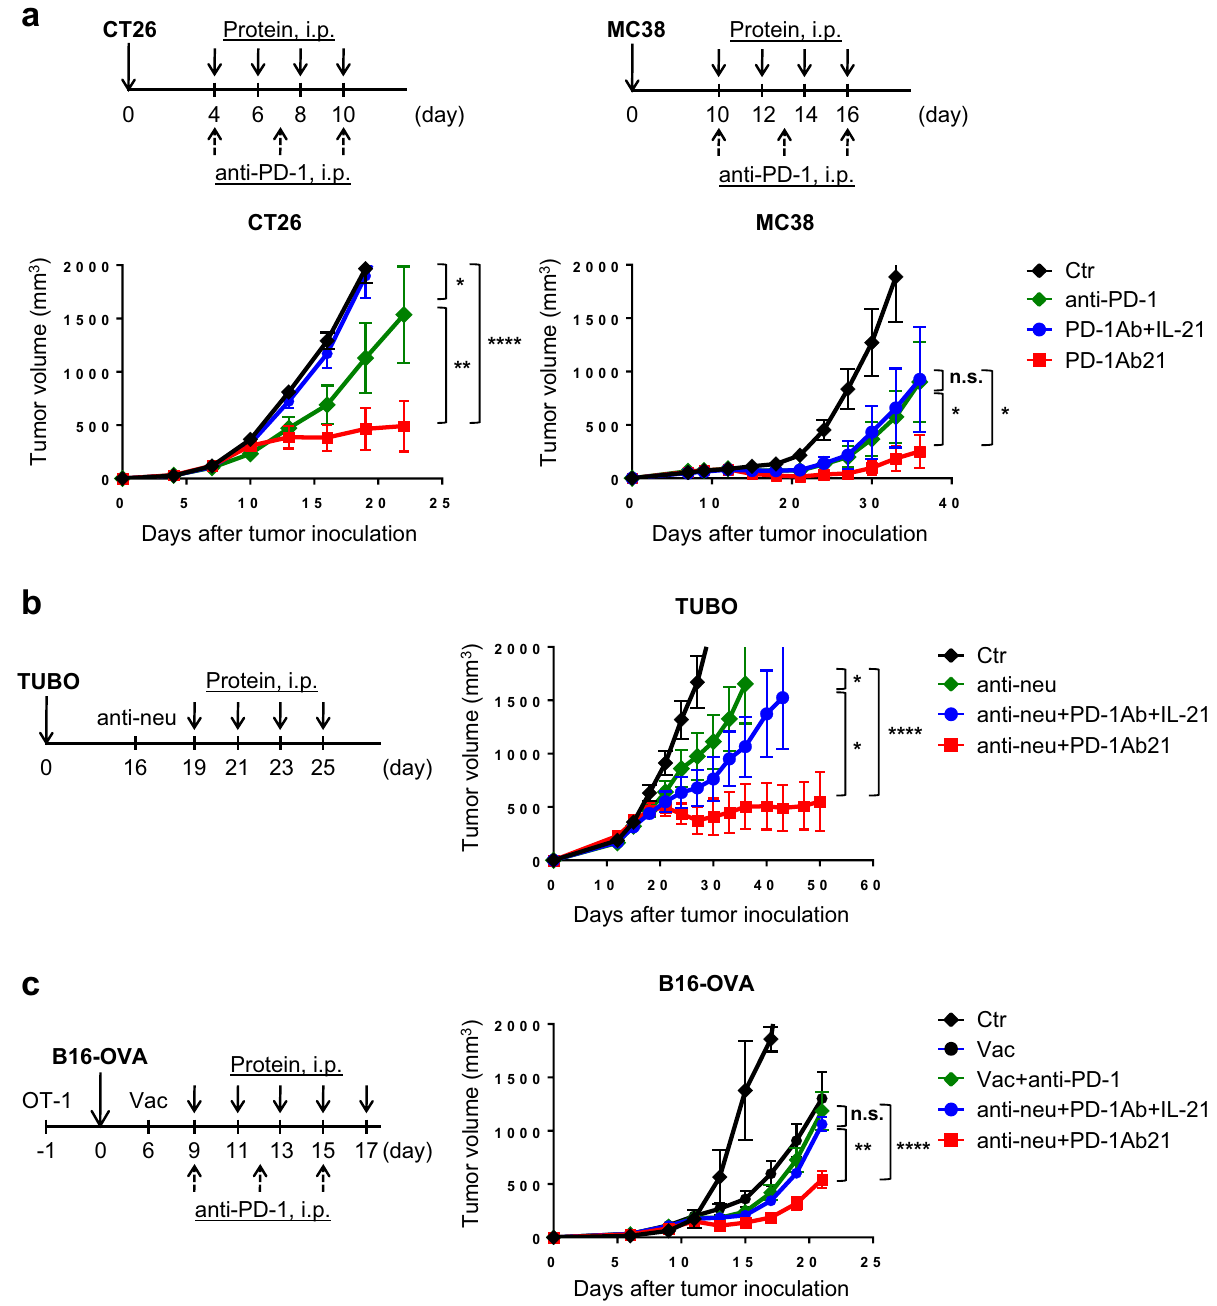
Fig. 5 Superior antitumor effect of PD-1Ab21 treatment. a Balb/c mice transplanted s.c. with CT26 cells (left) or C57BL/6 mice transplanted s.c. with MC38 cells (right) were treated with anti-PD-1, PD-1Ab + IL-21, or PD-1Ab21 ( n = 5 mice /group). b Balb/c mice ( n = 5 mice /group) transplanted s.c. with TUBO cells were treated with anti-Her2/neu antibody alone or in combination with PD-1Ab + IL-21 or PD-1Ab21. c C57BL/6 mice ( n = 5 mice /group) transferred with 1 × 10 6 naïve CD90.1 + OT-1 cells 1 d before inoculation of B16-OVA cells were immunized with poly I:C and OVA 257-264 peptide, followed by treatment with anti-PD-1, PD-1Ab + IL-21, or PD-1Ab21. Tumor length (a) and width (b) were measured and tumor volume was calculated as (ab 2 /2). Tumor growth is shown as mean tumor size ±SEM over time. Results were compared using two-way ANOVA followed by Tukey ’ s multiple comparison test. a CT26: * p = 0.0167, ** p = 0.0024, **** p < 0.0001; MC38: * p = 0.0445 (anti-PD-1 vs. PD-1Ab21), * p = 0.0242 (PD-1Ab + IL-21 vs. PD-1Ab21). b * p = 0.0223 (anti-neu vs. anti-neu + PD-1Ab + IL-21), * p = 0.0335 (anti-neu + PD-1Ab + IL-21 vs. anti-neu + PD-1Ab21), **** p < 0.0001. c ** p = 0.0015, **** p < 0.0001, n.s. not signi fi cant. One representative experiment out of three independent experiments is PD-1Ab21 further stimulated the robust expansion of OT-1 cells, and Supplementary Fig. 8a, b). However, the non-OT-1 CD8 + T cells did not increase in tumors of PD-1Ab21-treated mice. leading to a systemic high frequency of OT-1 cells, especially in (Supplementary Fig. 8c). The frequency of the OT-1 cells did not tumors. The frequency of OT-1 cells in TILs of PD-1Ab21-treated increase in DLNs, but dramatically increased in tumors of mice mice was about two times higher than that of anti-PD-1-treated treated with vaccination or vaccination plus PD-1 blockade mice, which accounted for more than 70% of CD8 + TILs (Fig. 6c